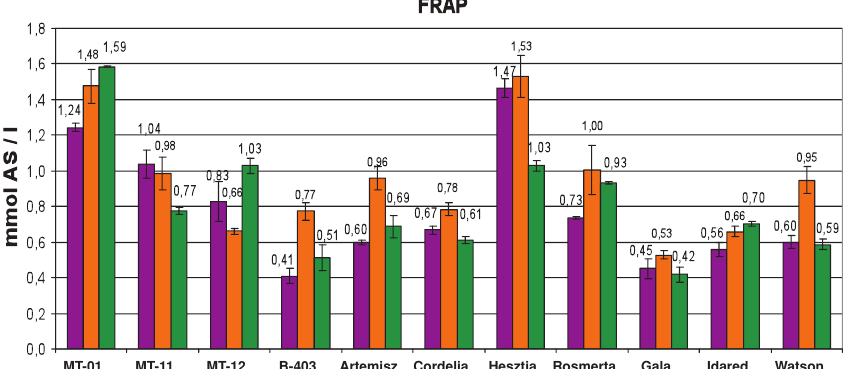
Figure 3. Water soluble antioxidant capacity (FRAP) of the fruits in eight new and three control varieties